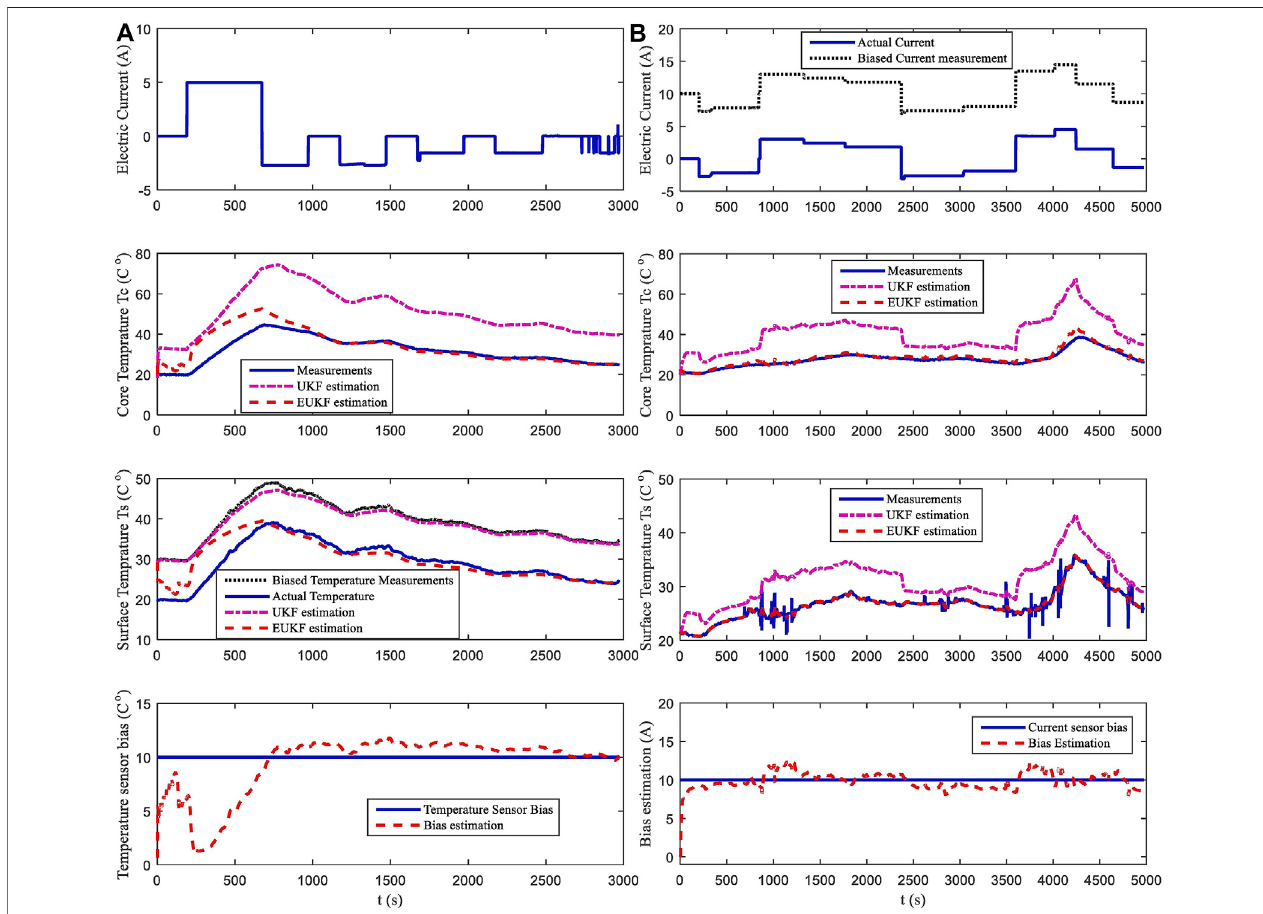
FIGURE 8 | Online estimation results for both UKF and EUKF during charging and discharging tests. (A) with a 10 ° C sensor bias in the surface temperature measurement (Sun et al., 2020; Panel 13, p. 11). (B) with a 10 A sensor bias in the current measurement with additional noise (Sun et al., 2020; Panel 14, p. 12). Reprinted from (Sun et al., 2020), Copyright (2020) with permission from